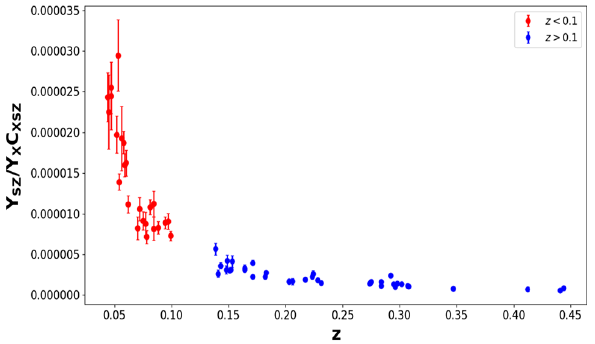
Fig. 1 61 Y SZ / Y X C XSZ galaxy clusters sample as a function of red- shift [33]. The z < 0 . 1 sample are shown by red data points used to estimate the universal constant C . The blue points show the sample z > 0 . 1 used to obtain the Hubble constant, H 0